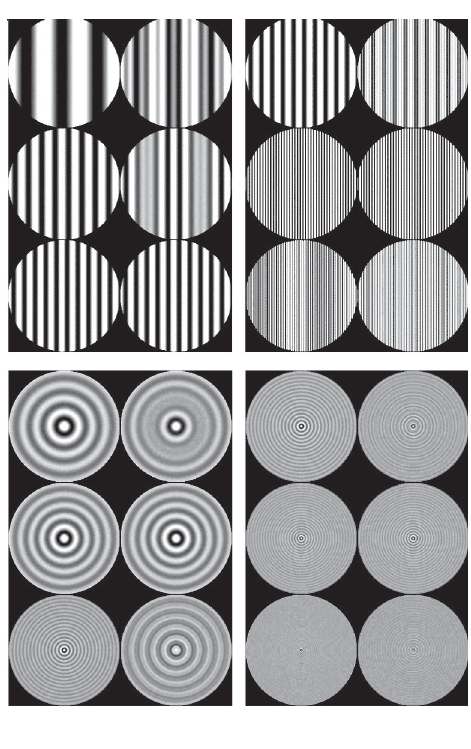
Figure 2. Contrast sensitivity for sine-wave gratings and radial fre- quency stimuli. Grand mean of contrast sensitivity values ob- served in the measurement of both CSF (contrast sensitivity function) and rCSF (radial con- trast sensitivity function). These are measurements made on the standard low-contrast reso- lution monitor (A) and on a Sony BVM-1910 RGB-TV-video moni- tor, a high-contrast resolution monitor (B). In A , the CSF maxi- mum sensitivity occurs around 2.0-3.0 cpd whereas that for the rCSF occurs around 1.0 cpd. In B , CSF maximum sensitivity occurs around 3.0 cpd whereas that for the rCSF occurs around 0.8-1.0 cpd. Error bars are standard errors of the mean at the 99% confidence level interval. All the differences between respective point estimates of each function were statistically significant at P < 0.01 ( t -test for correlated